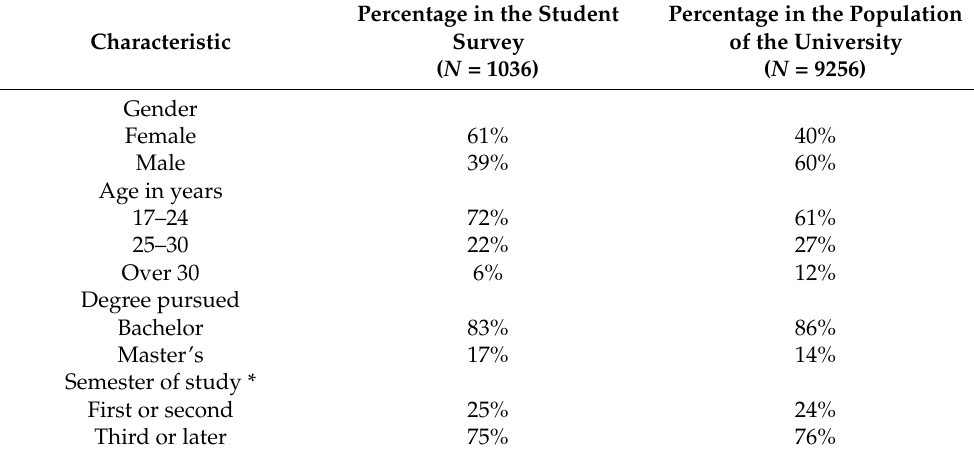
Table 1. Representativeness of the participants. Characteristic